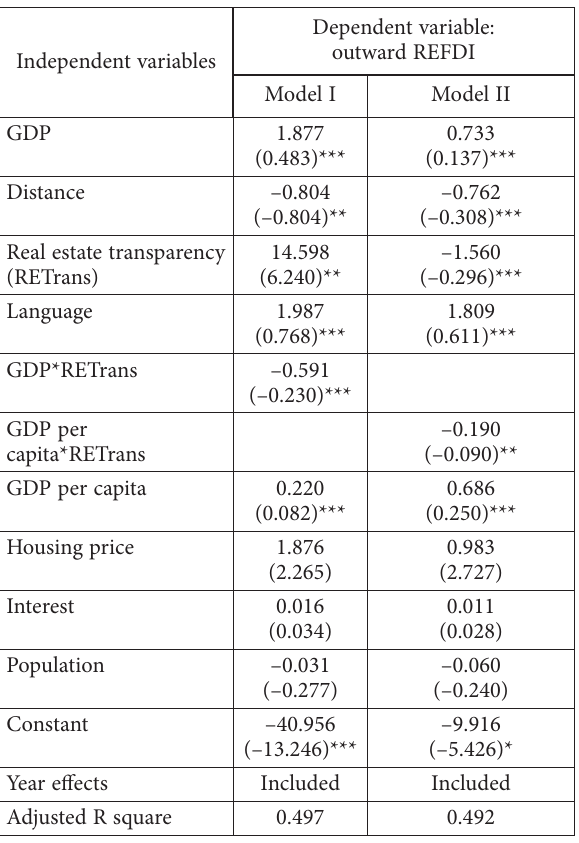
Table 5. Asymmetric effect of institutional